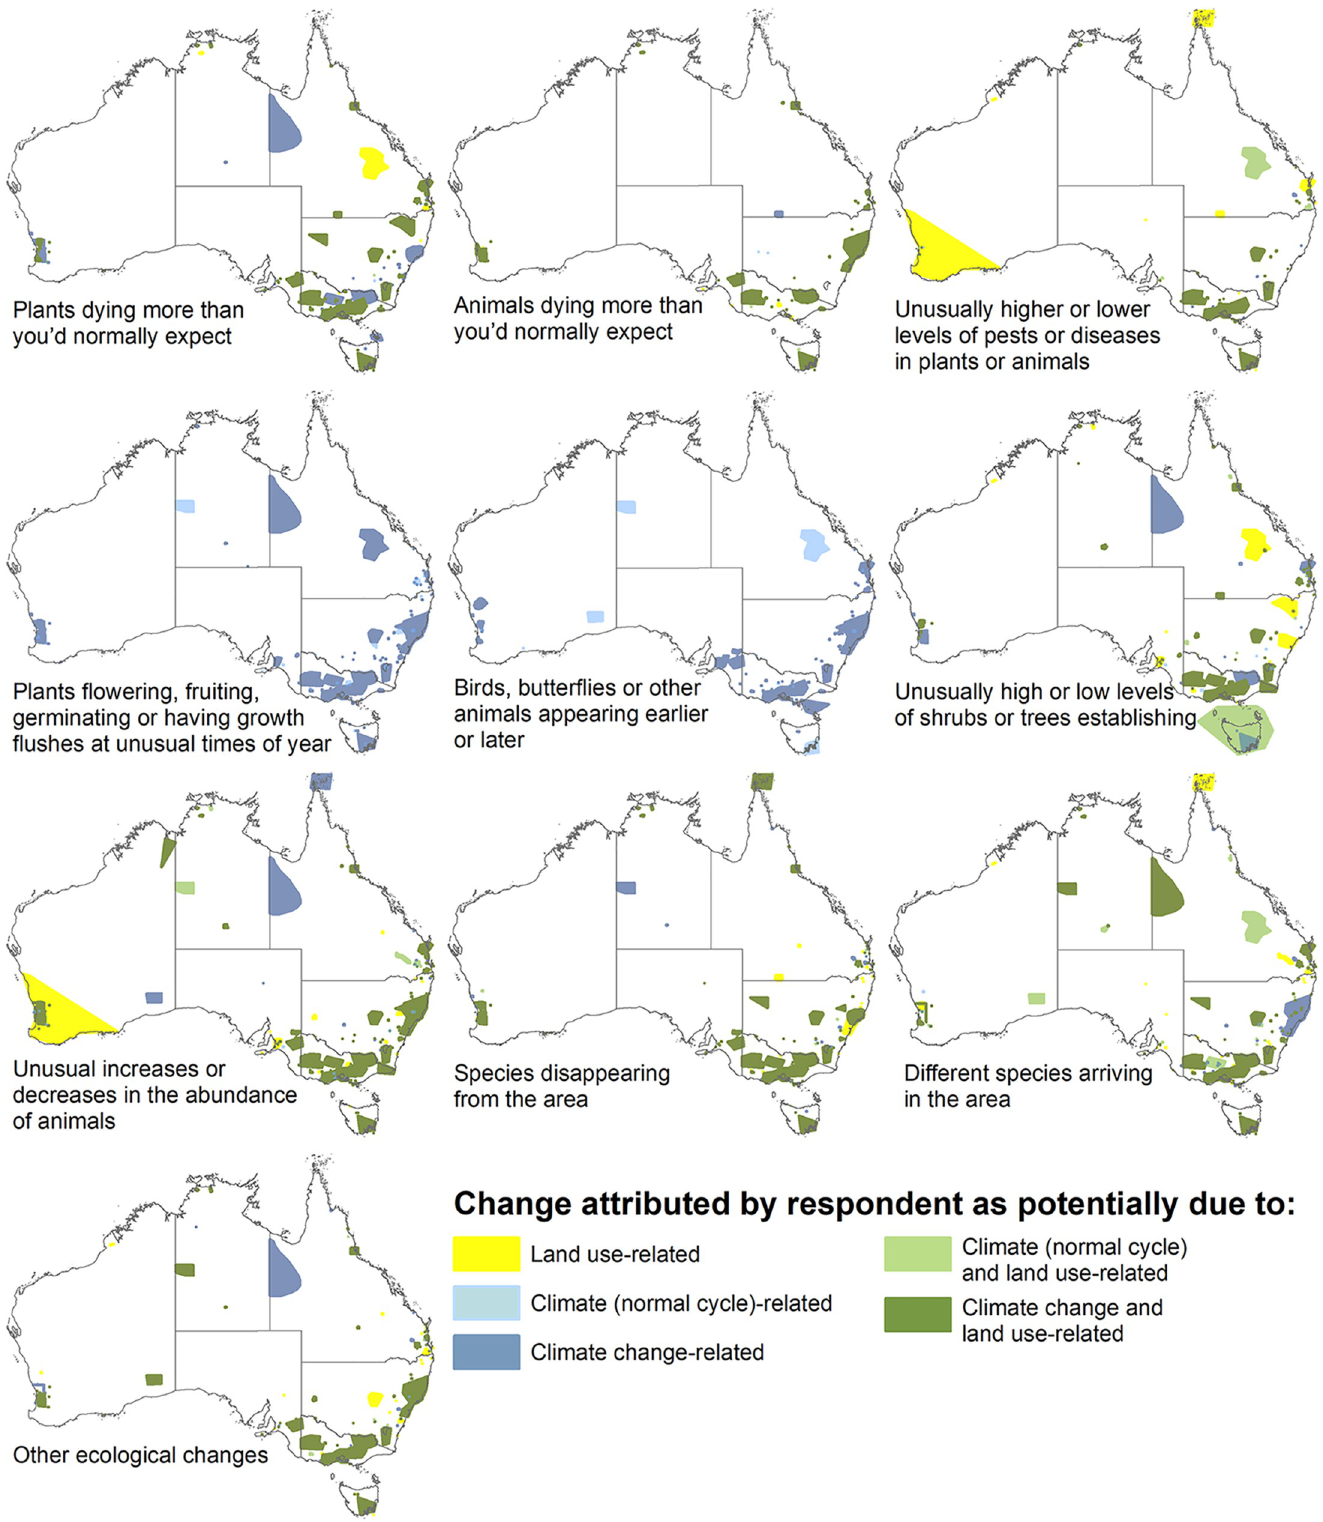
Fig 2. Location of ‘selected areas’ for which respondents had observed an ecological change relevant to each primary change type. Uses Part 1 multiple-choice scores and shows also where change was attributed to combinations of potential land use, climate (scored as ‘normal cycle’) or climate change (scored as unprecedented or climate change)